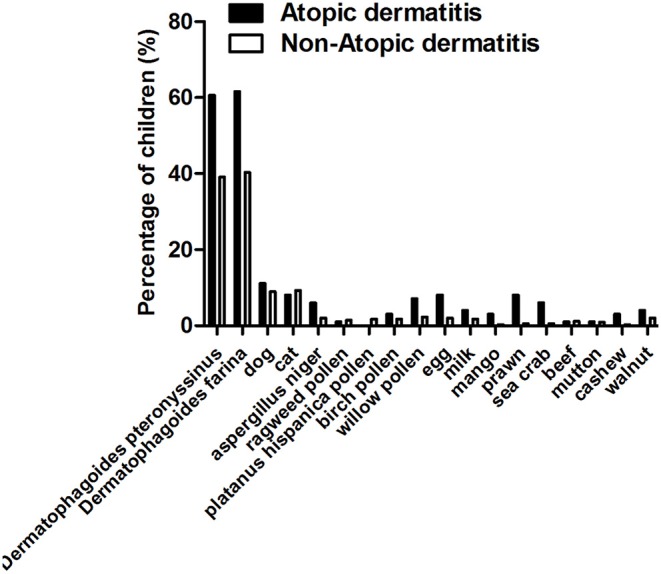
Frequency of positive allergic sensitization in Shanghai Allergy Cohort stratified by AD. The particular type of allergy sensitization in each group was calculated. Percentages of children with positive allergic sensitization in either group were analyzed. The x-axis shows the particular type of allergy sensitization. The y-axis shows the percentages of children with positive allergic sensitization in either group.